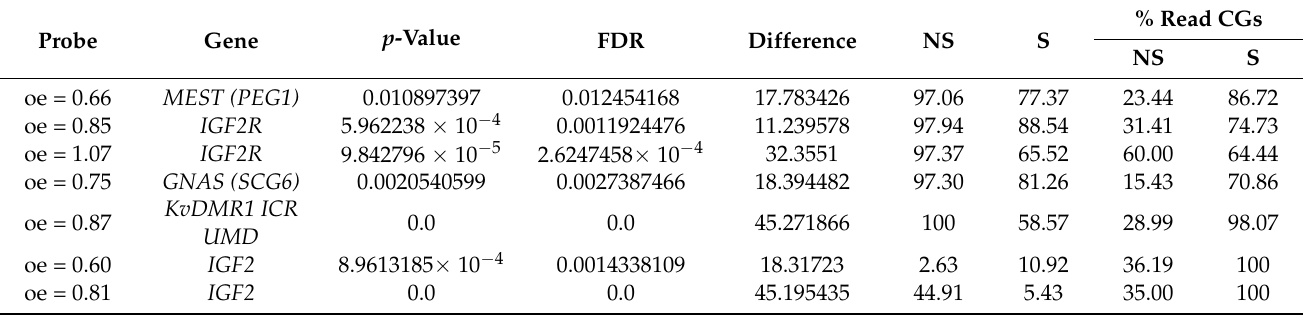
Table 3. Significantly different ( p < 0.05) percentages of methylation in non-stimulated (NS) and